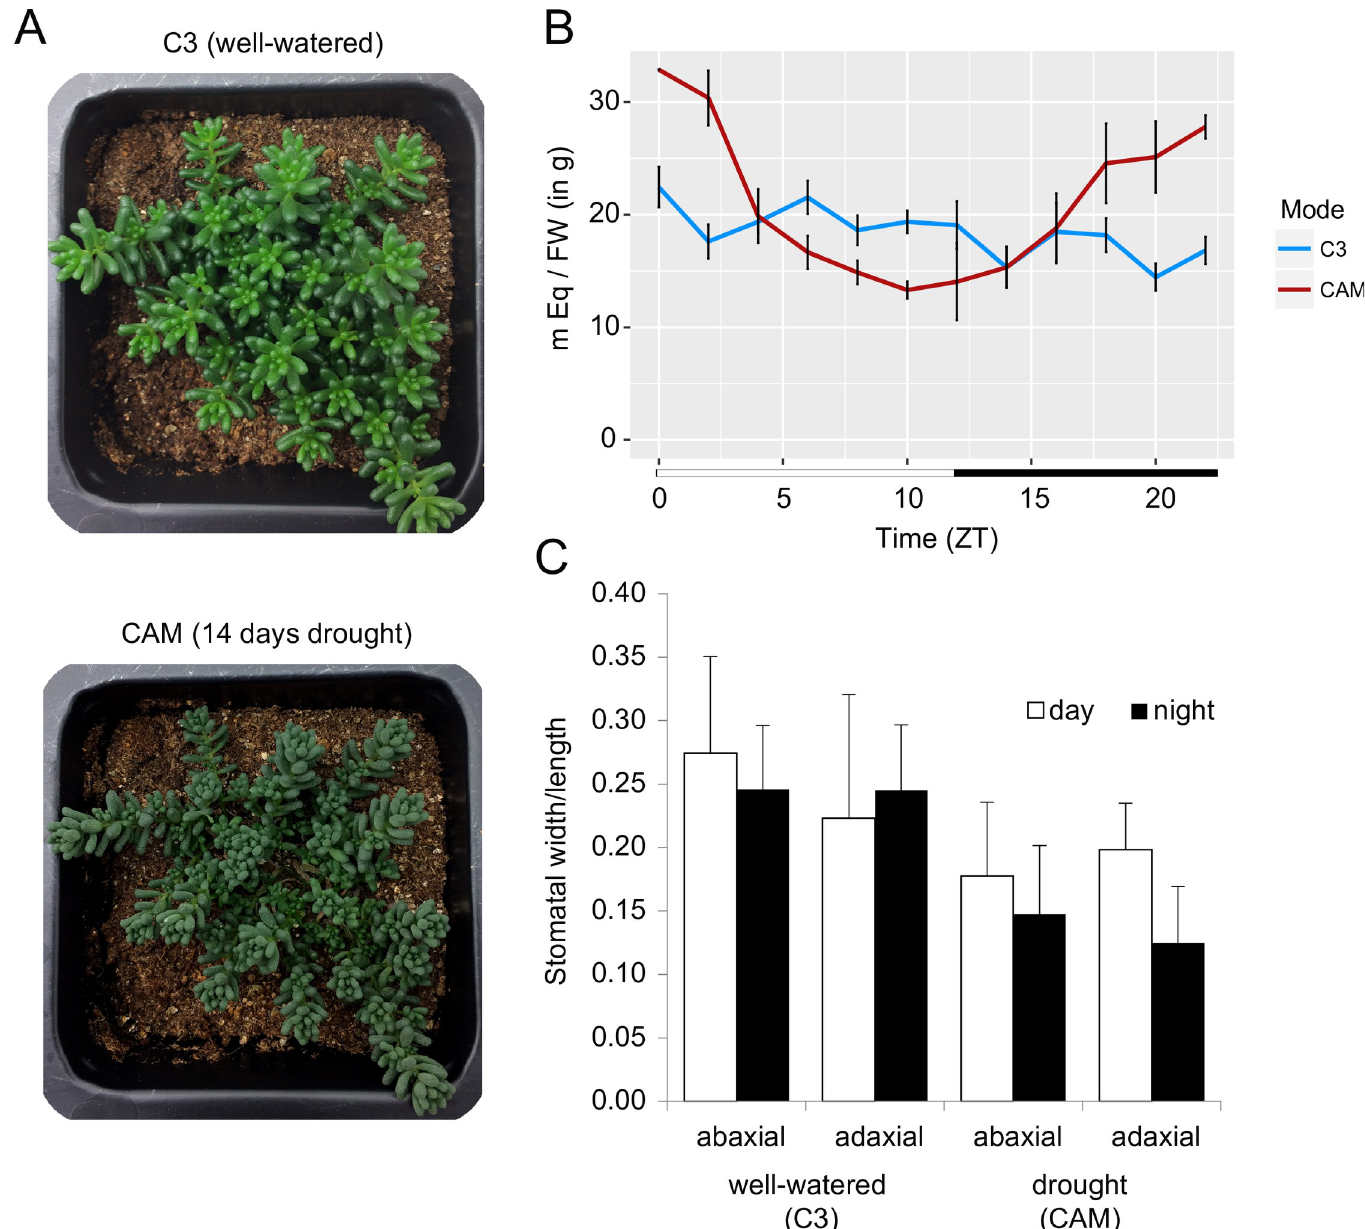
Fig 2. Overview of drought induced CAM-cycling in Sedum album . (A) Well-watered S . album plants performing C3 (top) and plants performing CAM-cycling after 14 days of drought (bottom). (B) Titratable acid of well-watered (C3) and drought (CAM) treated S . album across the surveyed timecourse. Three replicates were collected per timepoint. Standard error bars are shown. (C) Stomatal aperture in S . album . Stomatal width and length were measured diurnally (ZT06) and nocturnally (ZT22) in C3 and CAM-cycling conditions and divided to calculate aperture (n > 10). Standard deviation bars are shown.